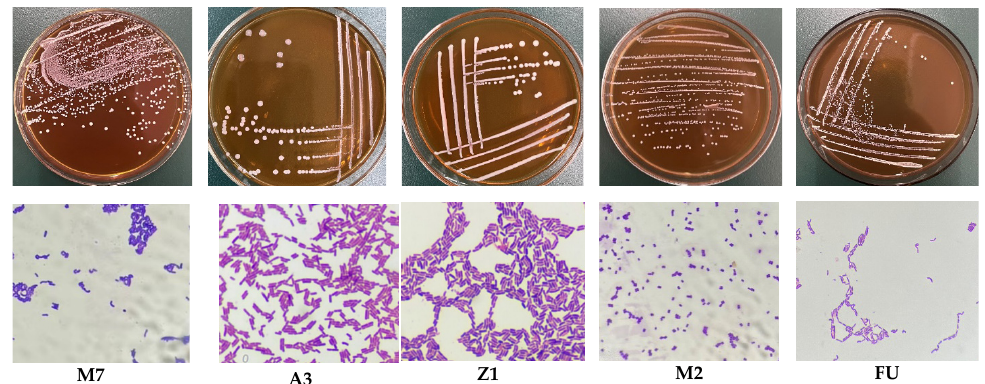
Figure 1. Some bacterial colony morphology similar to LAB, through microscopic examination. The